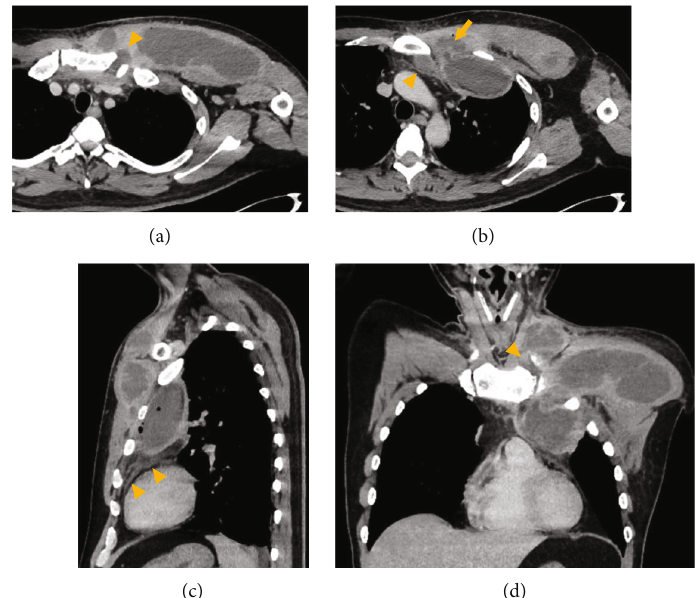
Figure 2: Contrast-enhanced chest computed tomography images in axial (a, b), sagittal (c), and coronal planes (d) on admission: (a) the infected joint enlarged the joint space (arrowhead); (b) the chest wall abscess was connected to the retrosternal abscess (arrowhead) and the extrapleural abscess via the fi rst intercostal space (arrow); (c) the retrosternal abscess was complicated by anterior mediastinitis (arrowheads); (d) pyogenic arthritis of the sternoclavicular joint (arrowhead) involved the neck, chest wall, and extrapleural space.